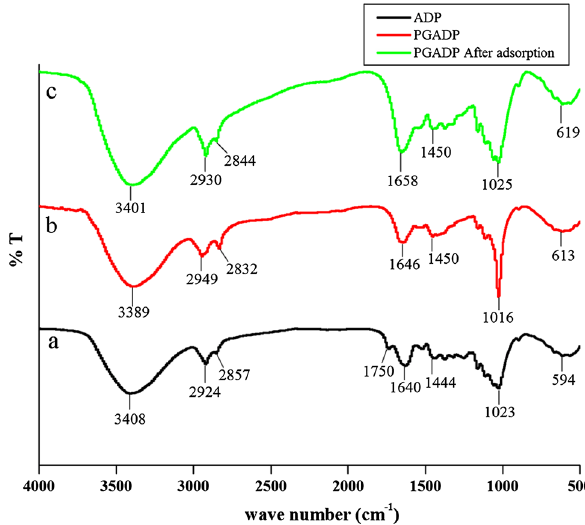
Fig. 5 FTIR spectra a raw ADP b PGADP c PGADP after CV adsorption